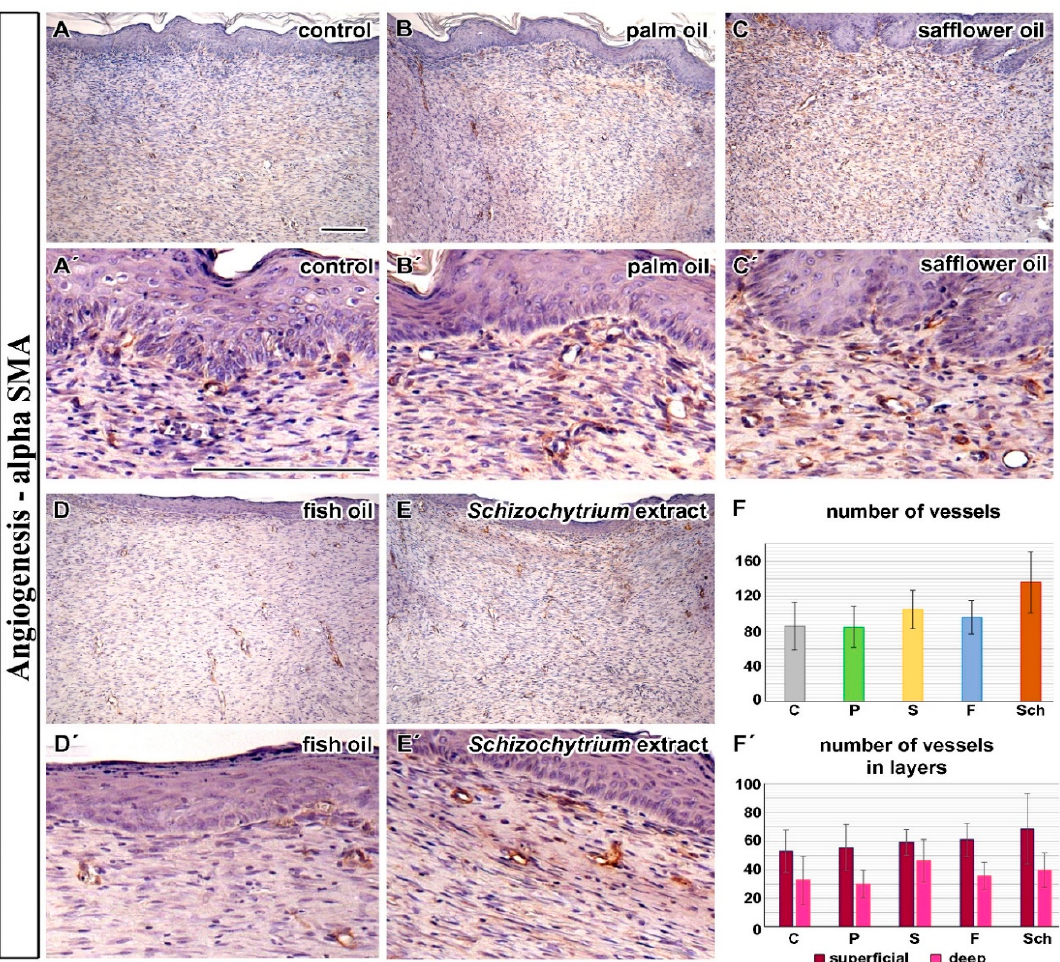
Figure 4. Immunohistochemical labeling of vessels by alpha-SMA. ( A – E , A’ – E’ ): Vessels were visualized by immunohistochemical labeling of alpha-SMA in individual treatments: control (C), palm oil (P), sa ffl ower oil (S), fish oil (F), and Schizochytrium extract (Sch) treated animals were analyzed 12 days after skin excision. ( F ): The number of vessels quantified on 10 histological sections for each treatment. ( F’ ): The number of vessels separately in the superficial and deep layer of the skin based on immunohistochemical labeling of alpha-SMA. Average values and standard deviations are displayed in both graphs. Di ff erences were not statistically significant (unpaired t -test; n = 10). Scale bar = 100 µ